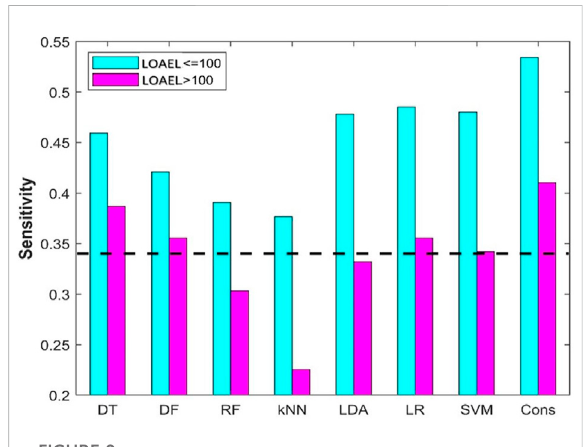
FIGURE 9 Sensitivity of positive chemicals with different LOAEL. The results from the eight machine models are indicated at the x -axis. The y -axis gives the prediction sensitivity. The sensitivities are plotted in cyan and pink bars for chemicals with LOAEL < 100 mg/kg/day and > 100 mg/kg/day, respectively. The black dash line represents the ratio of positive compounds in the training